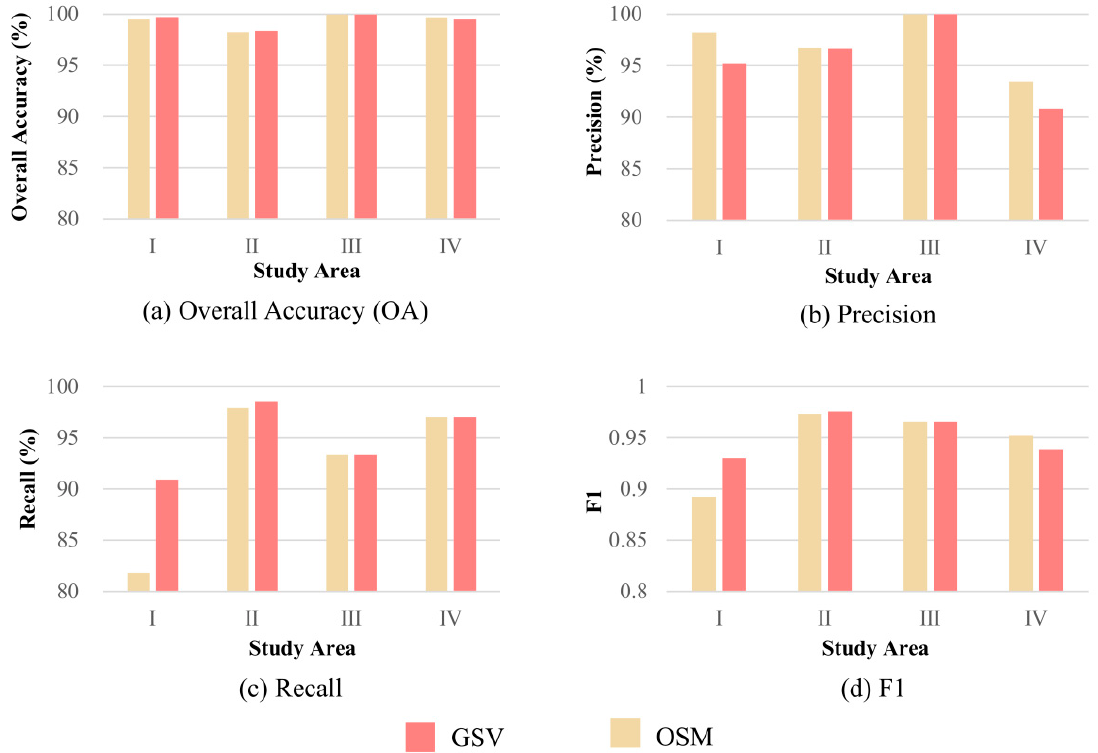
Figure 4. The evaluation results of two island datasets and four regions (I–IV), in terms of overall accuracy ( a ), precision ( b ), recall ( c ), and F1 ( d ).